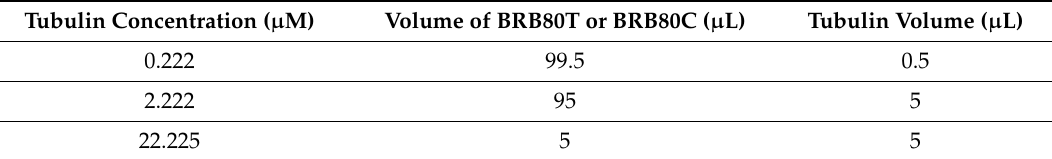
Table 1. Volumes of tubulin and bu ff er solution (BRB80T or BRB80C) used to stabilise